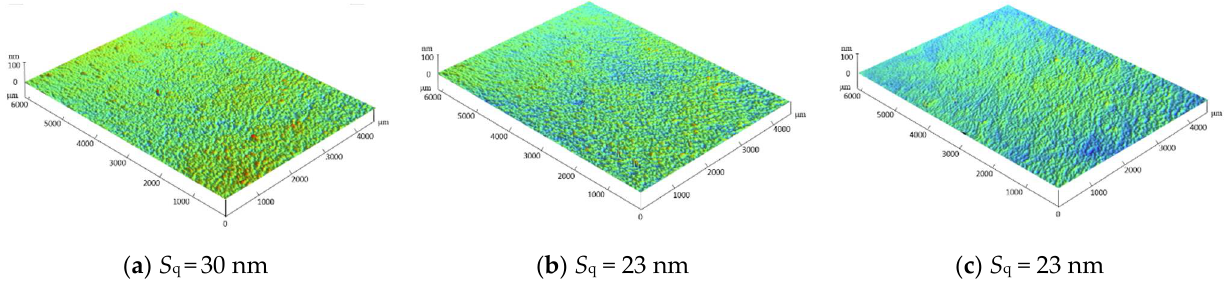
Figure 1. The surface morphologies: ( a ) YG10 substrates, ( b ) amorphous carbon (a-C) coating, ( c ) hydrogenated amorphous carbon (a-C:H) coating.